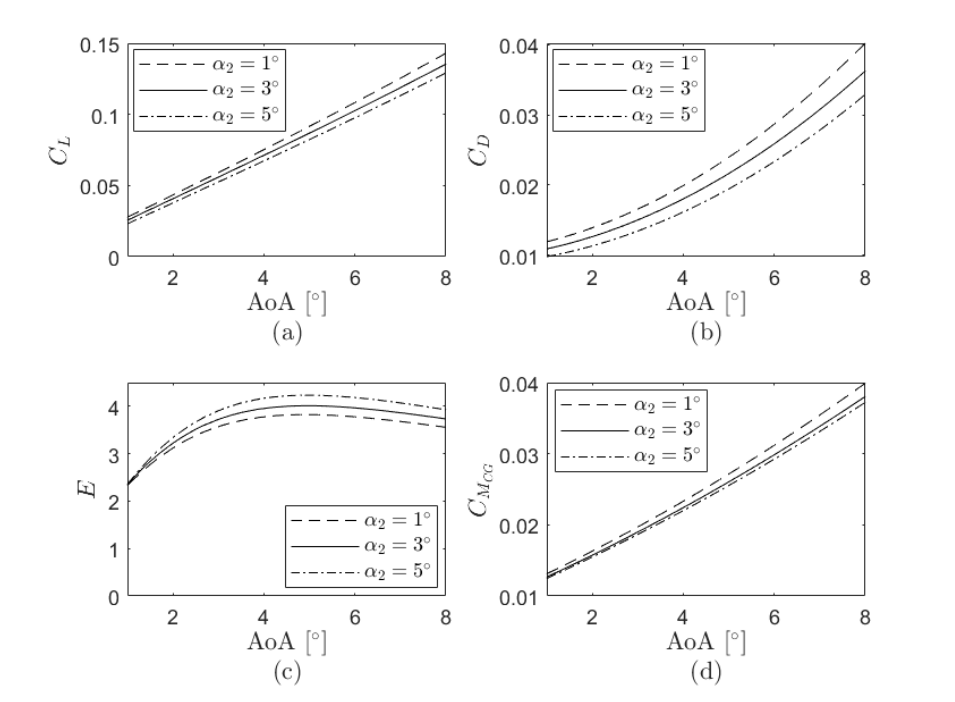
Figure 7. Variations of the aerodynamic parameters due to the modifications in α 2 , ( a ) C L vs. AoA , ( b ) C D vs. AoA , ( c ) E vs. AoA , ( d ) C M